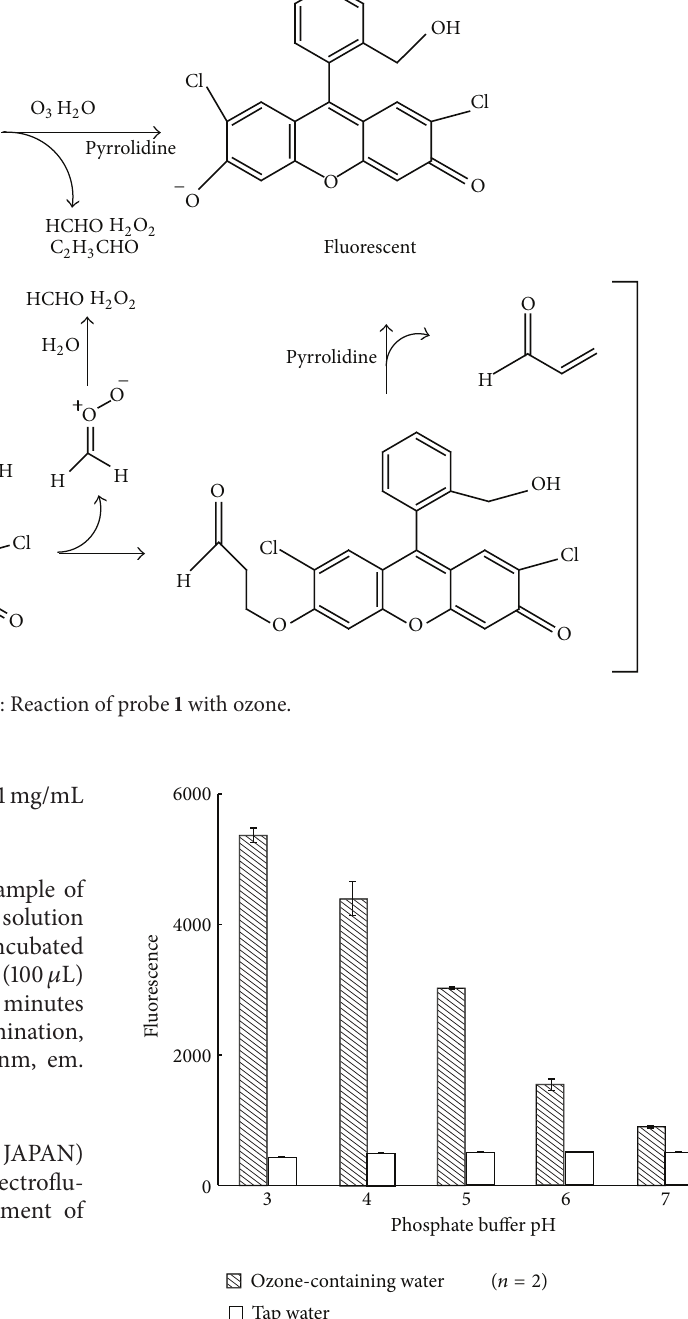
The effect of the salt concentration of the pH 3 phosphate buffer on fluoremetric method was investigated. As shown in Figure 3, the fluorescence intensities and S/N ratios increased as the concentrations of salt decreased. Therefore, we chose 0.5 mmol/L for the following